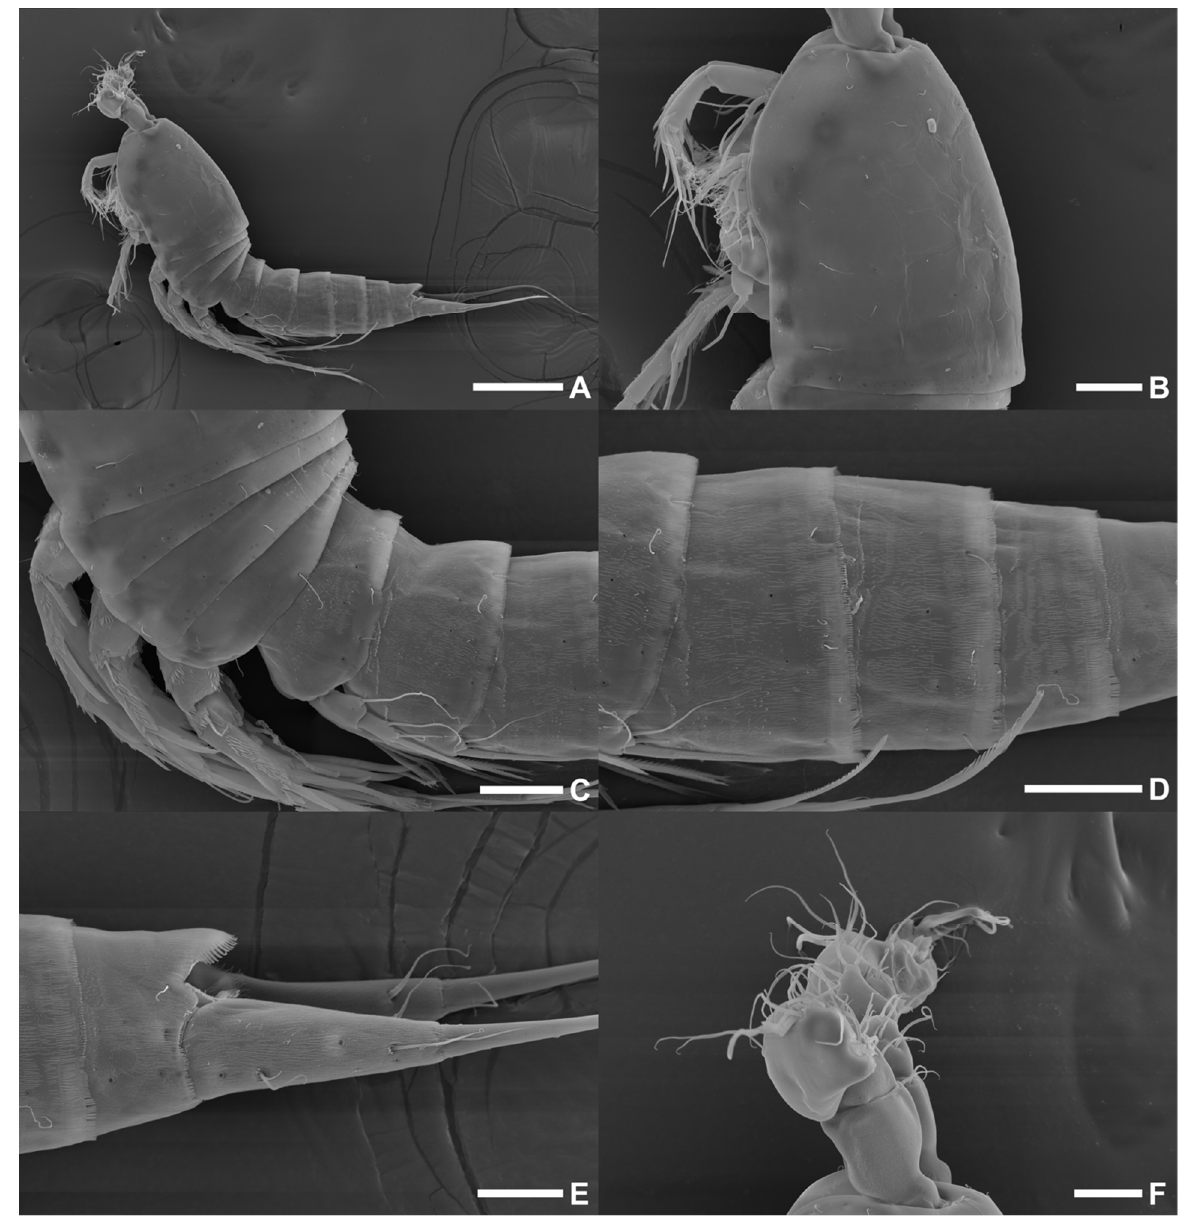
Figure 32. Scanning electron microscopy images of Phyllopodopsyllus similis sp. nov. male (paratype 23) in lateral view: ( A ) habitus; ( B ) cephalothorax; ( C ) second prosomite to the second urosomite; ( D ) third to fifth urosomites; ( E ) anal somite and caudal rami; ( F ) antennule. Scale bars: ( A ) 100 µm; ( B – D ) 30 µm; ( E , F ) 20 µm.